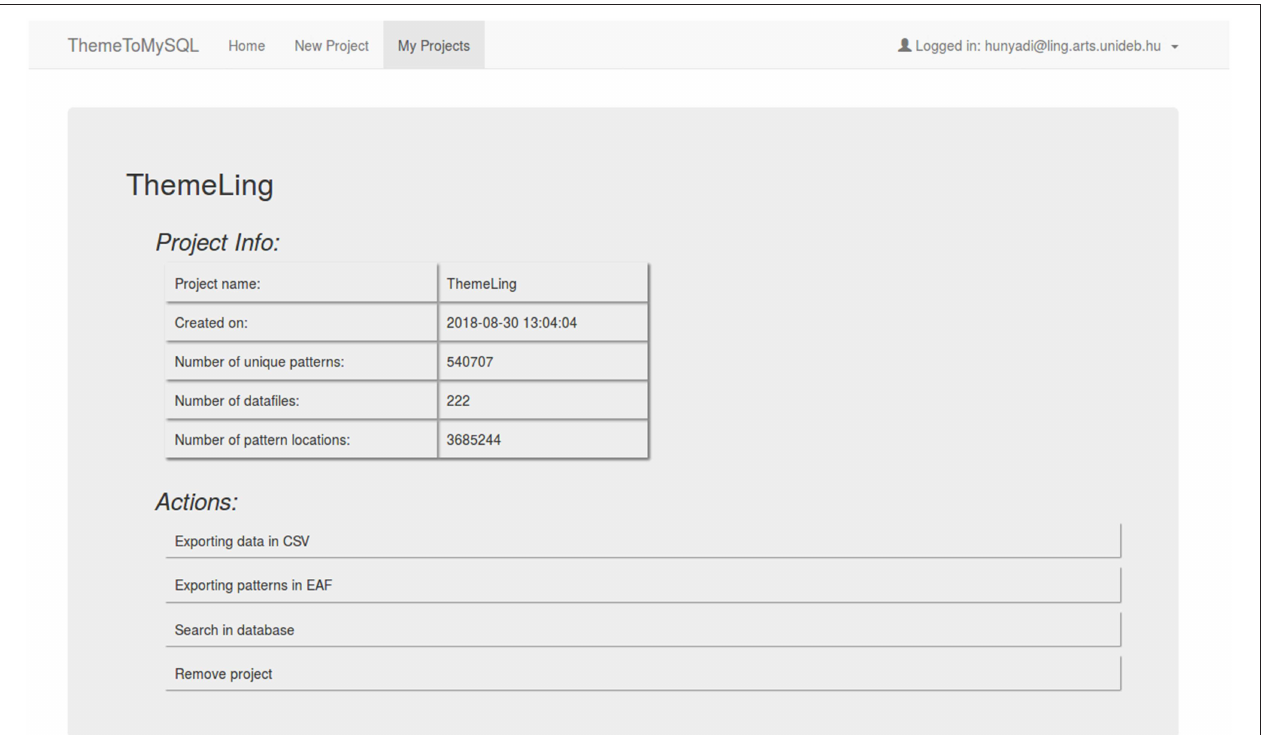
Frontiers in Psychology |